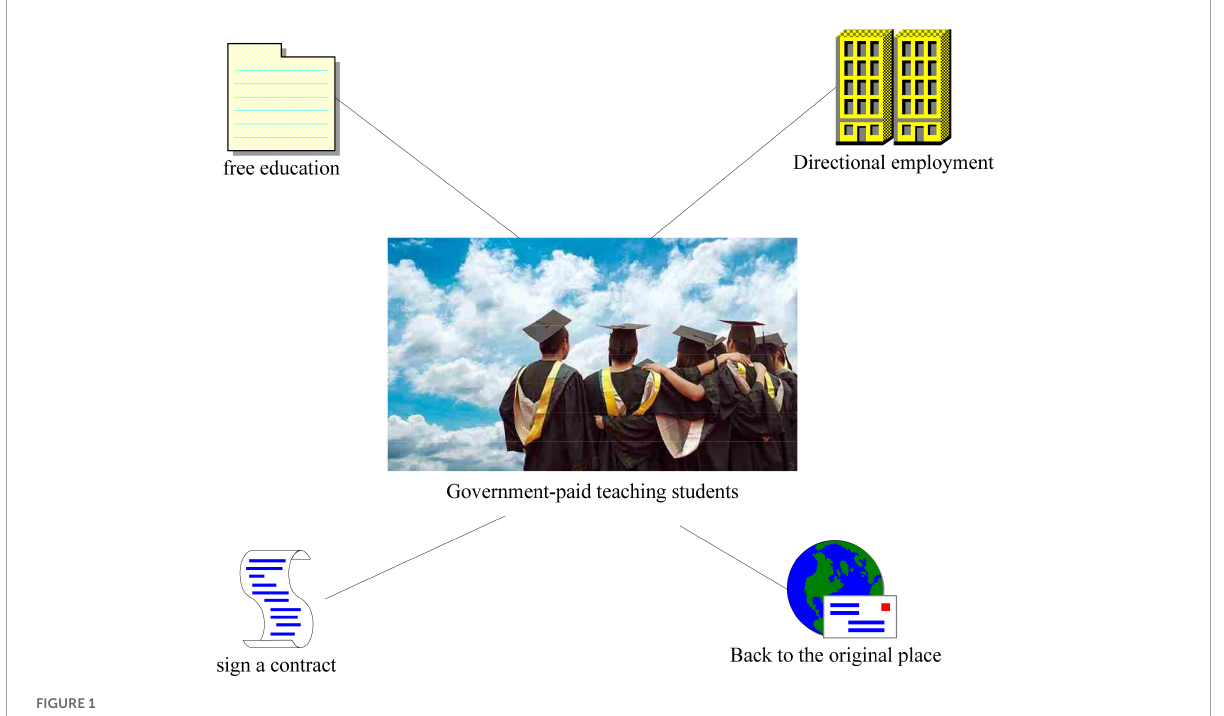
FIGURE1 Characteristics of public-funded normal